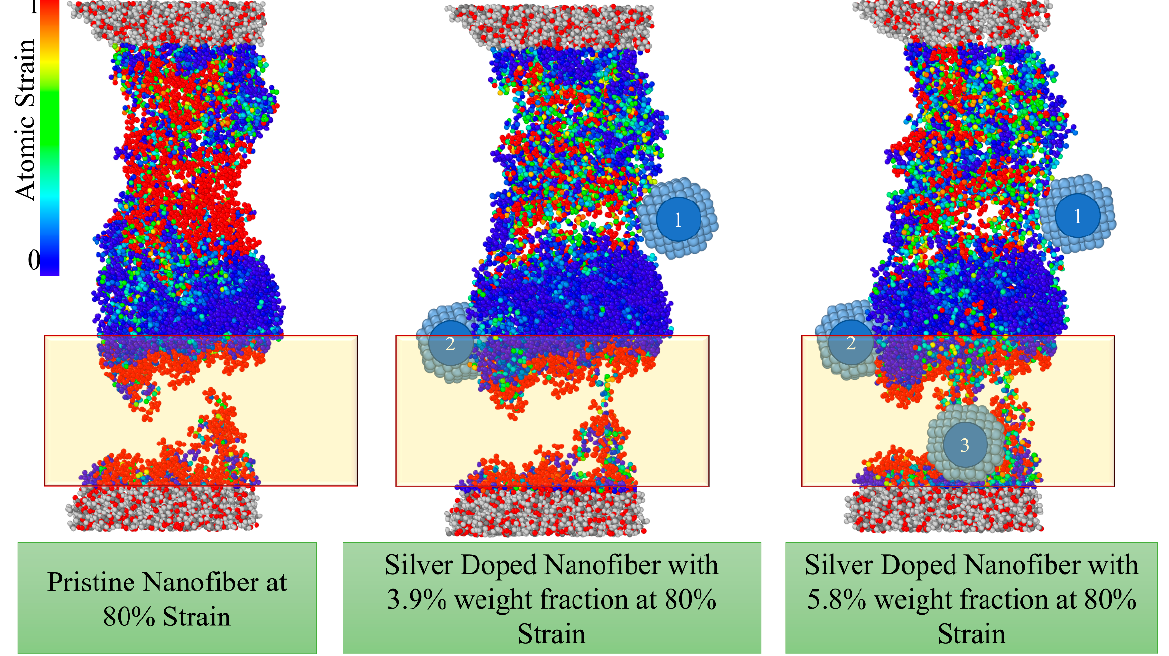
Figure 11. The effect of the weight fraction of nanoparticles on the strain distribution and fracture.